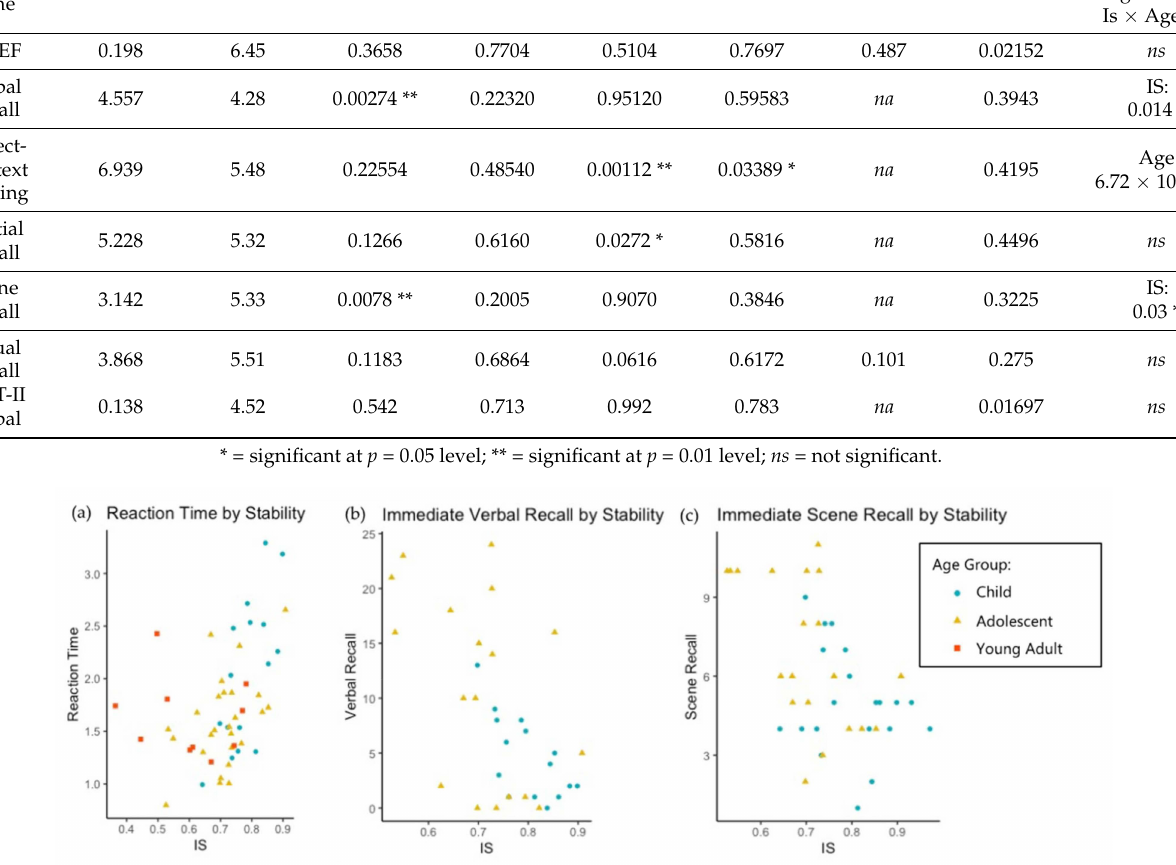
Figure 5. Interdaily stability and cognitive measures for participants with DS. ( a ) Reaction time was positively correlated with IS, but examining the relationship by age, there is preliminary evidence of a different relationship for adults (red squares). ( b ) Immediate verbal recall had a negative correlation with IS. ( c ) Immediate scene recall had a negative correlation with